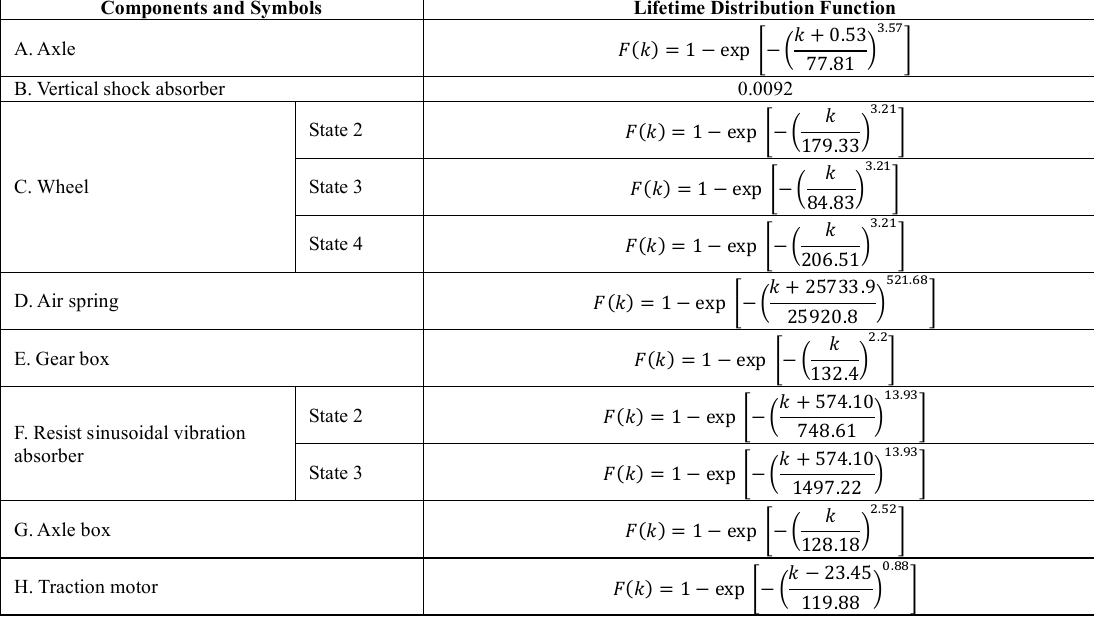
Table 3. Lifetime distribution functions of the bogie system